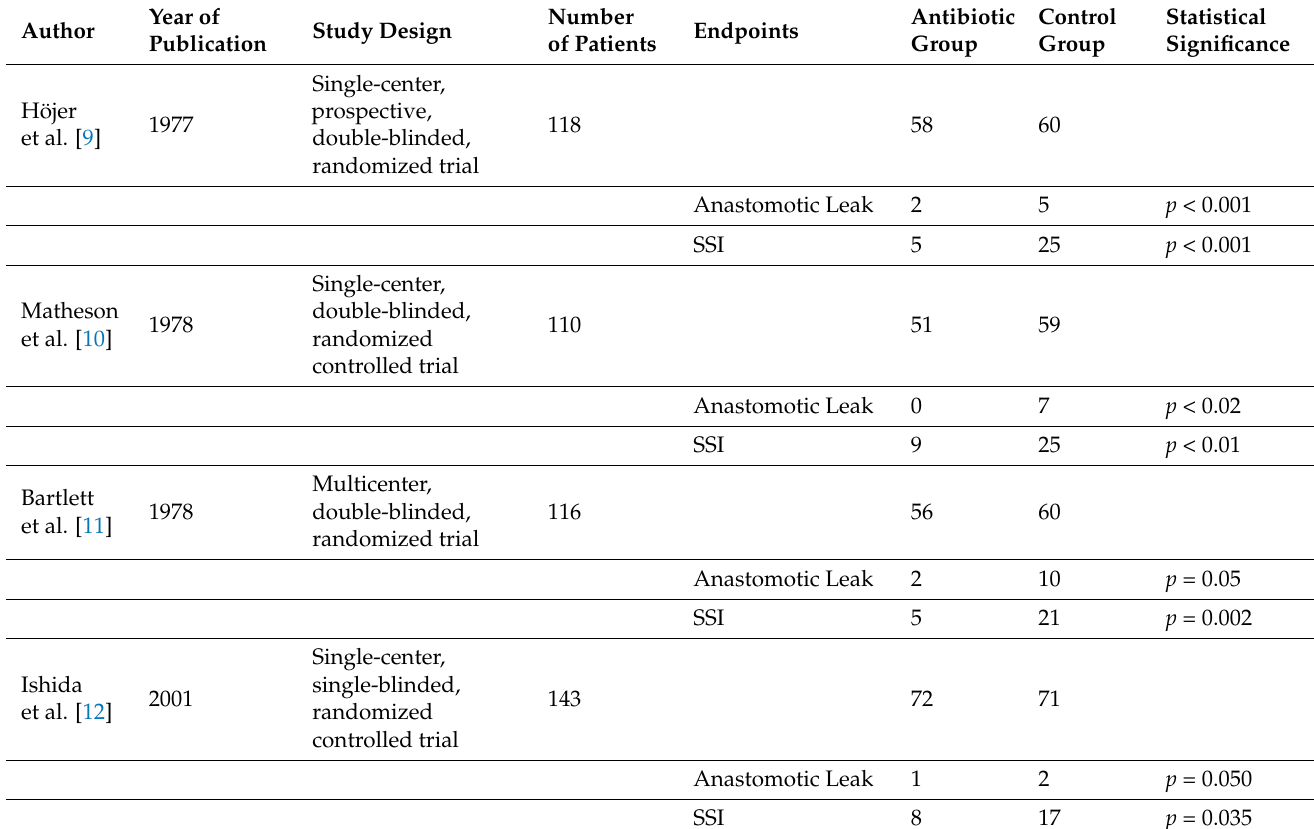
Table 3. Characterization of included